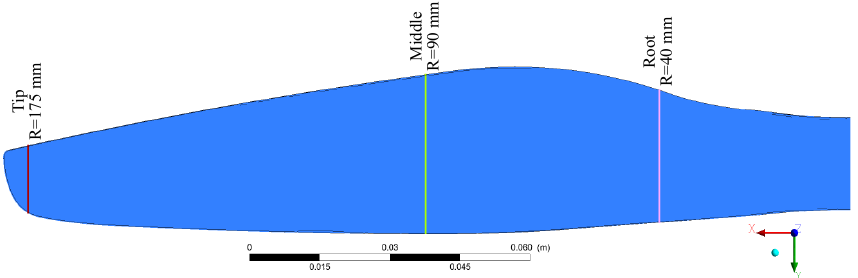
Figure 9. Planes for different sections along the